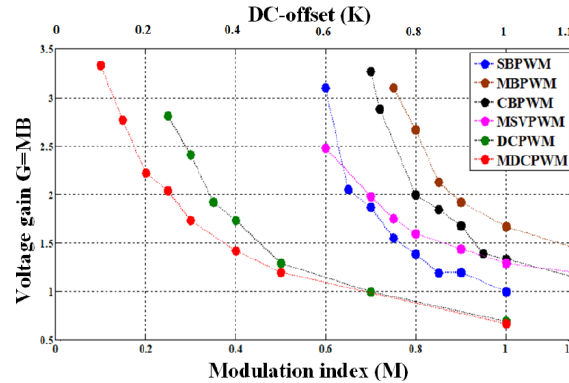
Figure 12. Experimental output three-phase line current for modified ZSI-DCPWM with highly inductive load 𝑍 𝐿 = 50 + j95 Ω.